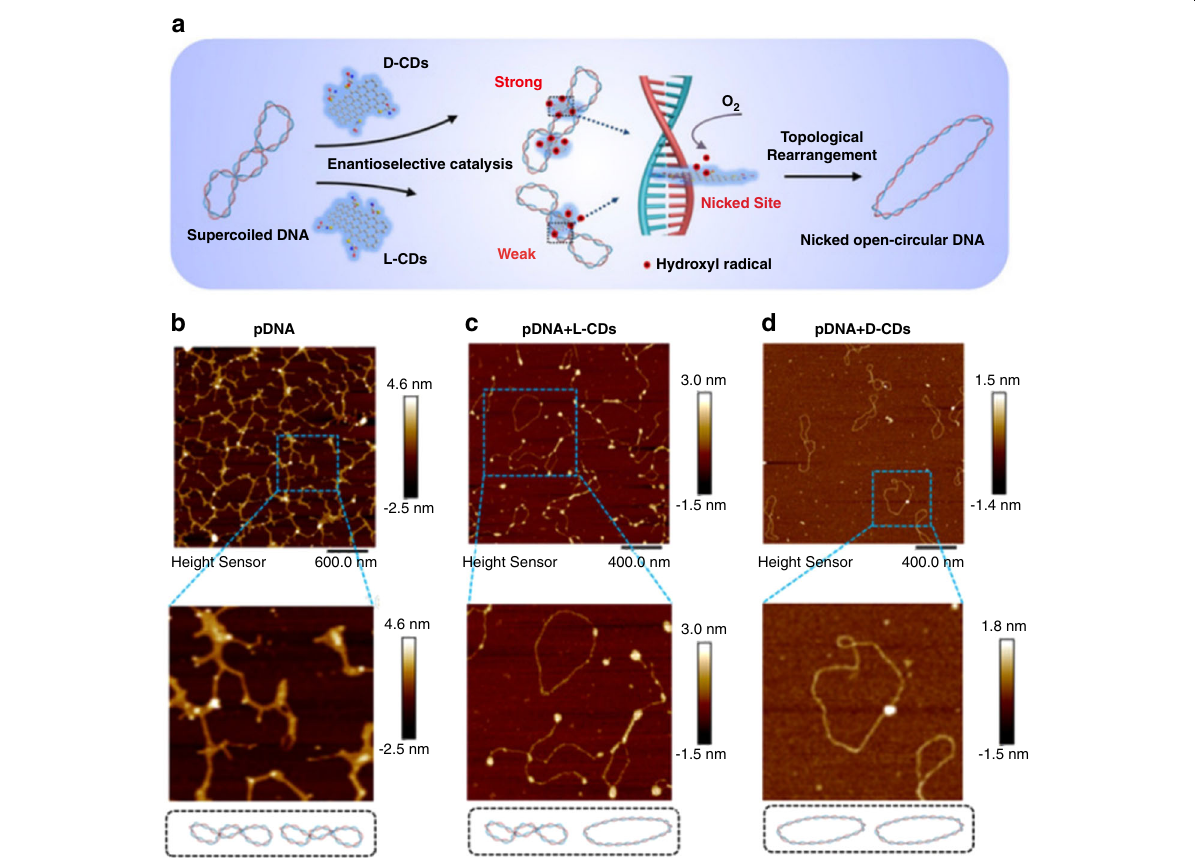
Fig. 9 Enantioselective chiral carbon-dot-mediated topological rearrangement of supercoiled DNA. a Schematic illustration, and b – d AFM images of pristine pDNA ( b ), pDNA treated with l-cysteine capped CDs ( c ), and pDNA treated with d-cysteine capped CDs ( d ). Figure taken with permission from 61 Copyright 2020 Wiley-VCH